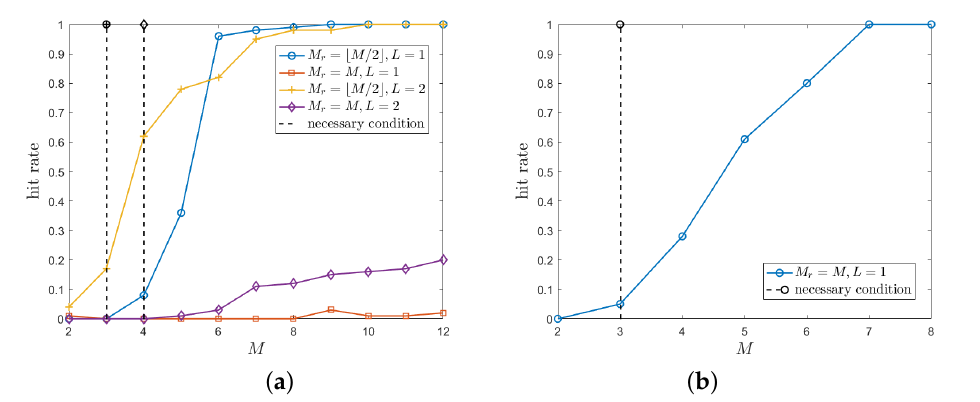
Figure 8. Hit rate w.r.t. M with the same or different δ m for m = 1, . . . , M . ( a ) Different δ m . ( b ) The same δ m